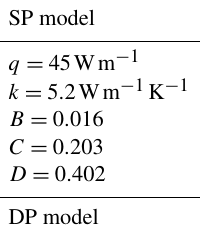
Table 3. Synthetic SP and DP model inputs. SP